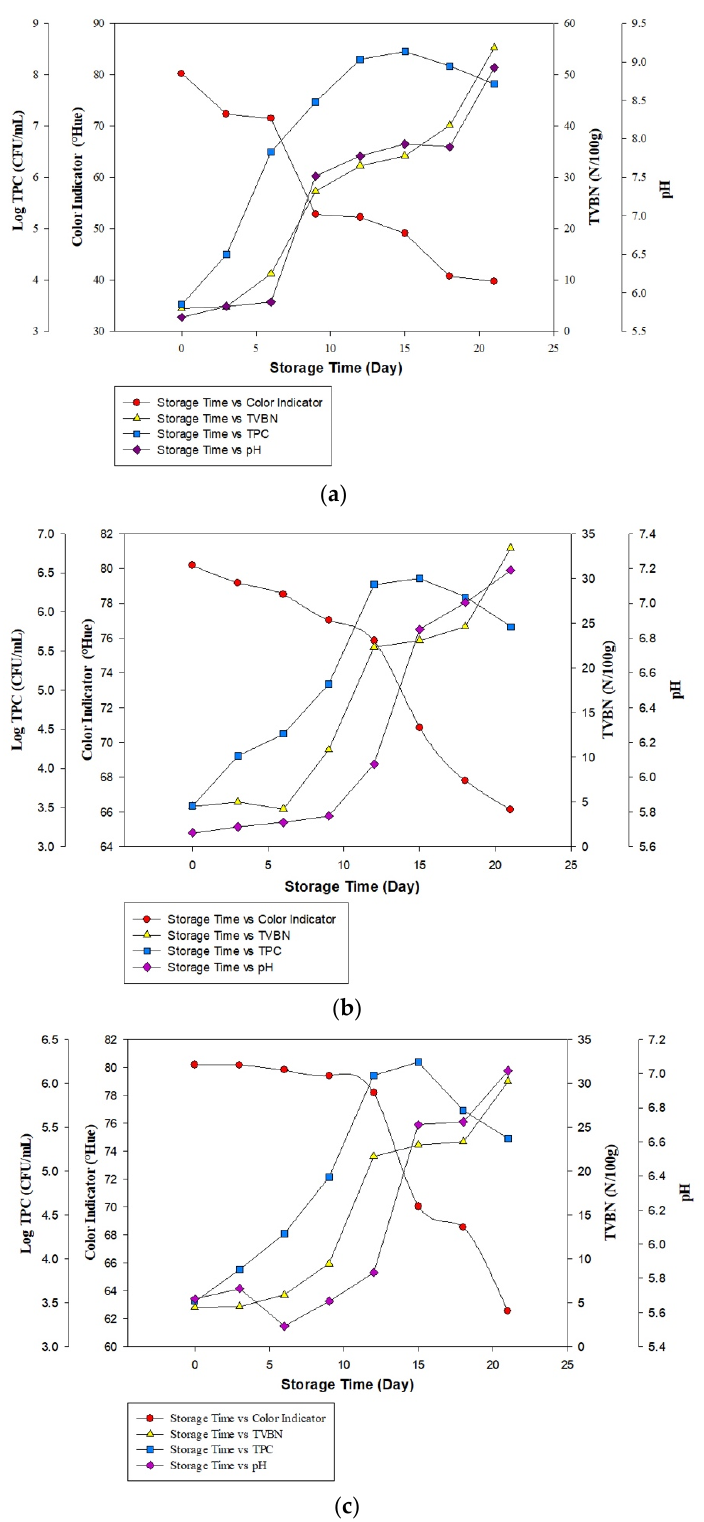
Figure 5. Correlation of color change on intelligent indicator label with all beef spoilage parameters with the garlic extract addition: ( a ) control, ( b ) 15%, and ( c ) 20%.